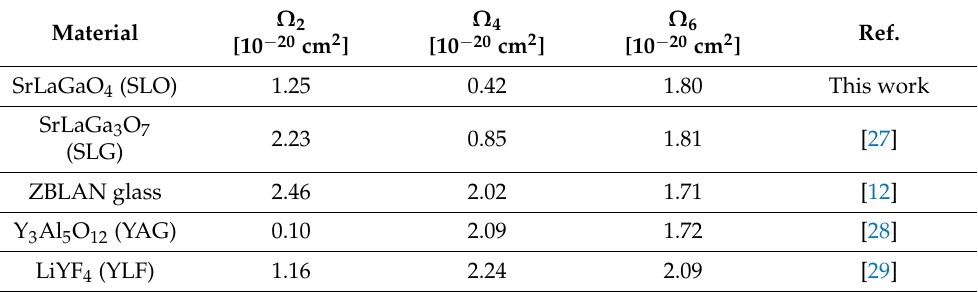
Table 2. Calculated Judd–Ofelt intensity parameters for SrLaGaO 4 :Ho 3+ compared with several Ho 3+ ion activated